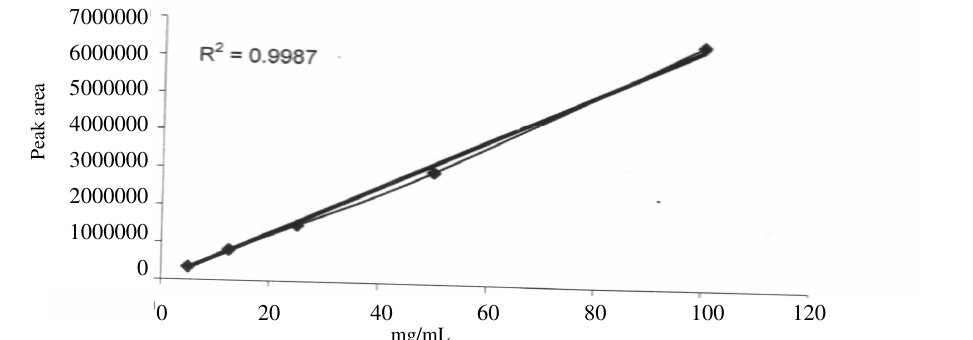
Figure 2. Calibration curve of